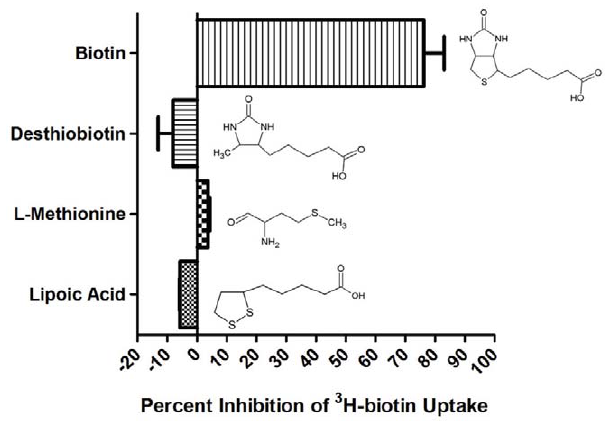
Figure 5. Specificity of transport for 3 H-biotin. Bacterial samples were incubated with 10 nM 3 H-biotin and 1 m M of competitor at 30 u C for 1 minute. Reactions were then halted and the amount of radioactivity in the samples was determined. Values are reported as the percent inhibition of 3 H-biotin uptake compared to a no inhibitor